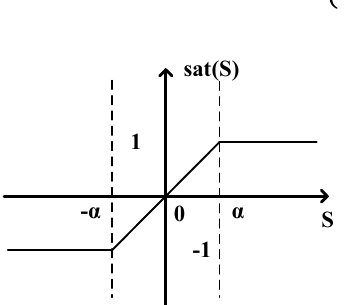
Figure 8. Symbolic function 𝑠𝑔𝑛(𝑠) .